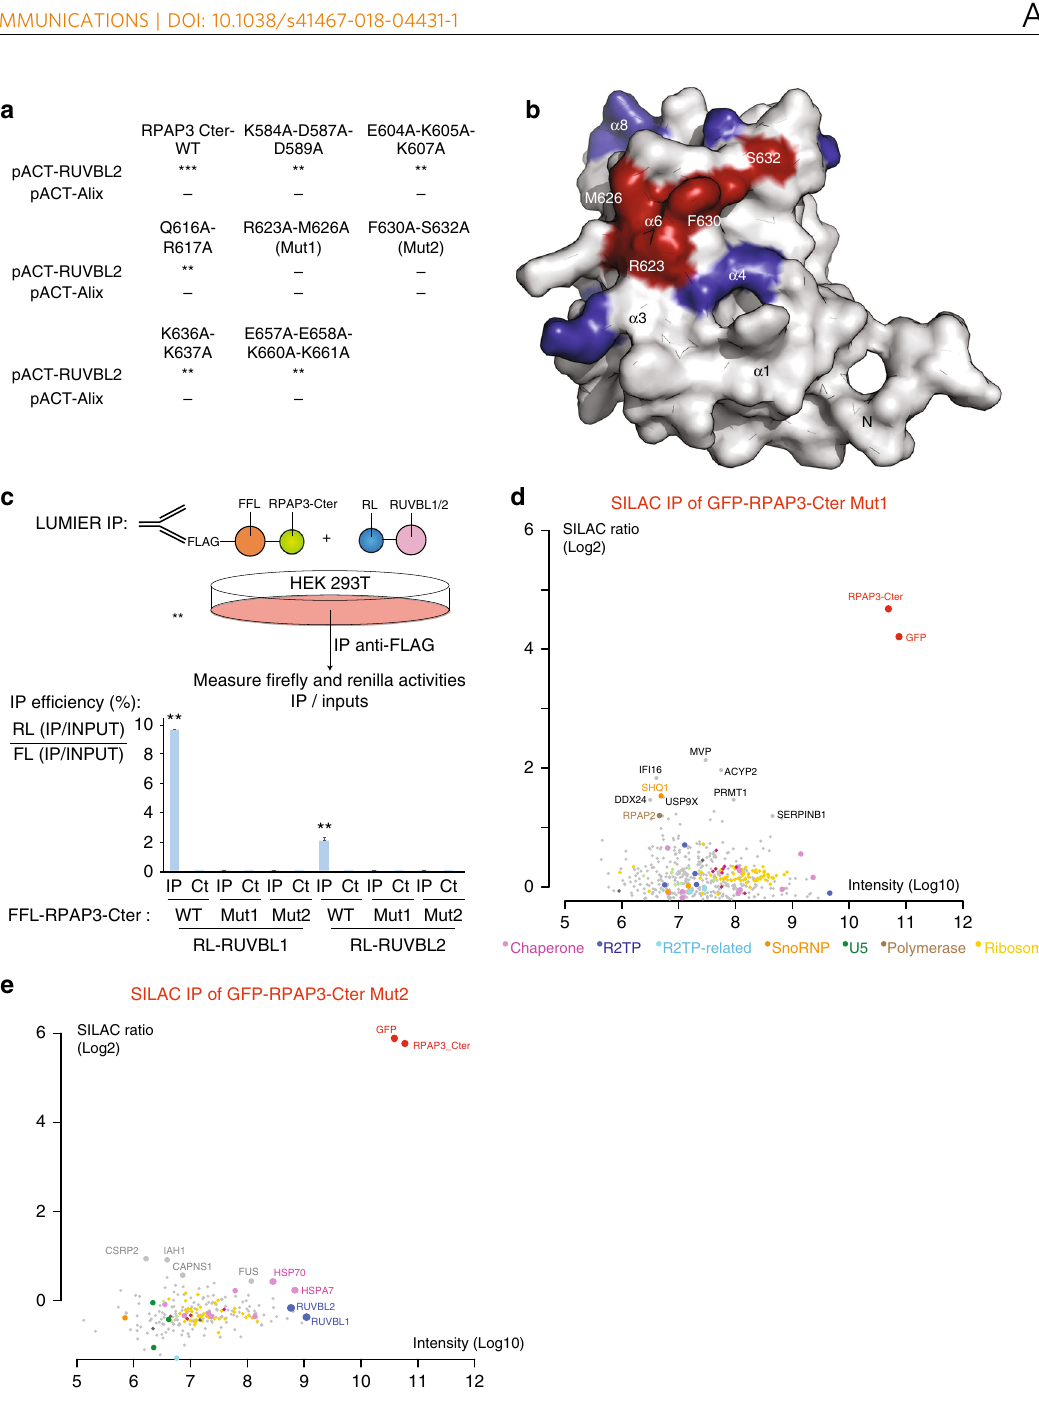
Fig. 3 The RPAP3 C-terminal domain interacts with R2TP clients via RUVBL1/2 multimers. a Yeast two-hybrid analysis of interactions between RUVBL2 and RPAP3-Cter mutants. Alix is a negative control. ***: strong interaction; **: medium; *: weak; − : no interaction. b Molecular surface representation of RPAP3-Cter structure by specifying the location of the mutants that lost interaction with RUVBL1/2. c LUMIER assay showing the in vivo interaction between RPAP3-Cter and RUVBL1/2 mutant proteins. Top panel: schematic representation of the assay. Bottom panel: graph plotting the IP ef fi ciency of the indicated proteins. The values are the IP ef fi ciencies of the co-precipitation of the RL fusion proteins (IP/Input), normalized by the IP/Input values obtained with the anti-FLAG IP of the 3xFLAG-FFL fusion protein. Error bars: standard deviation. Stars: values signi fi cantly greater than six-times the mean value obtained in the control IPs without anti-FLAG antibody (Ct). ** p -value < 0.001 (Z-test). d,e SILAC proteomic analysis of the partners of RPAP3-Cter- Mut1 and RPAP3-Cter-Mut2, respectively. Legend as in Fig.